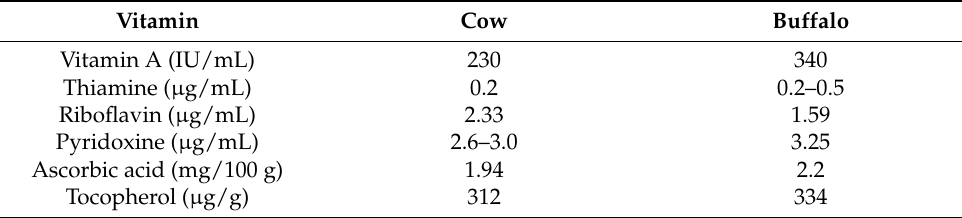
Table 7. Vitamins content in buffalo and cow milk. Vitamin Cow Buffalo Vitamin A (IU/mL) 230